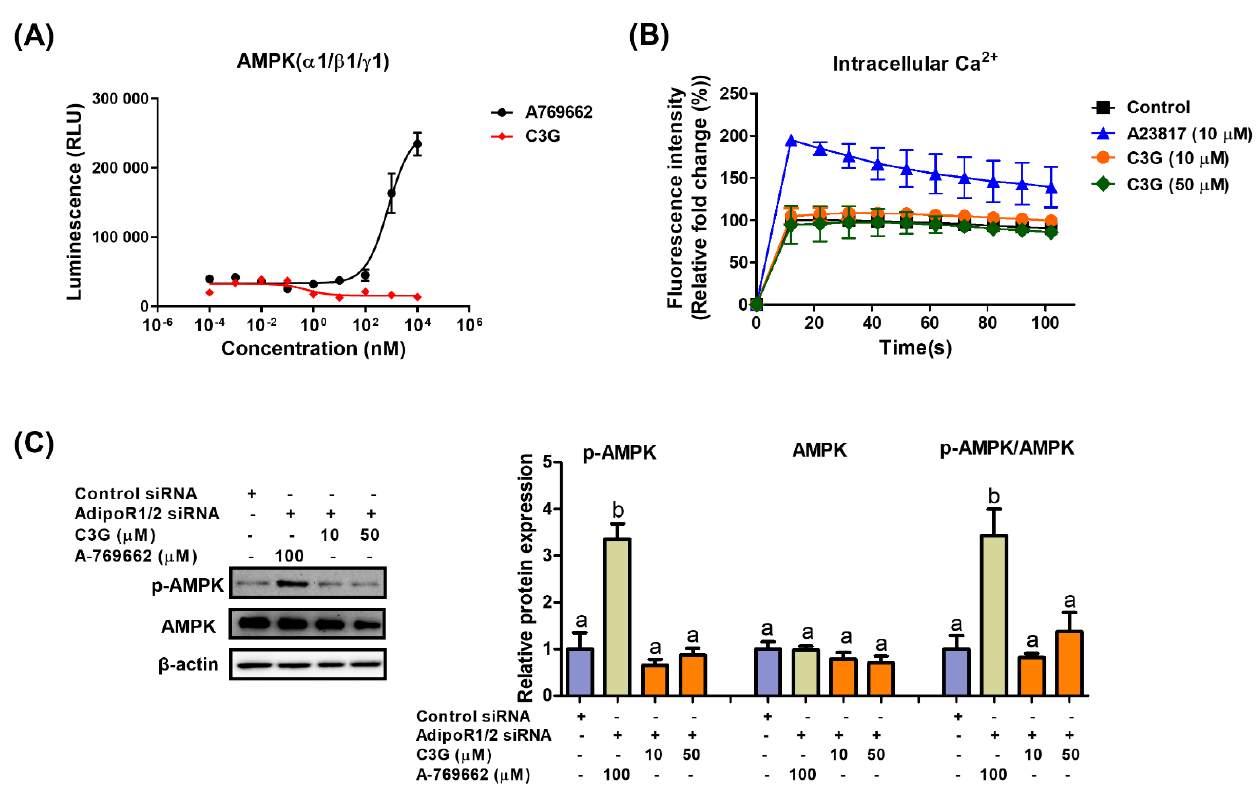
Figure 3. Mechanism through which C3G activates AMPK. ( A ) In vitro AMPK kinase assay. ( B ) Analysis of intracellular calcium in HepG2 cells stimulated with A23817 or C3G. ( C ) AMPK phosphorylation in cells following AdipoR1/2 gene knockdown. For multiple-group comparisons, one-way ANOVA was performed. Different letters indicate significant differences at p < 0.05.